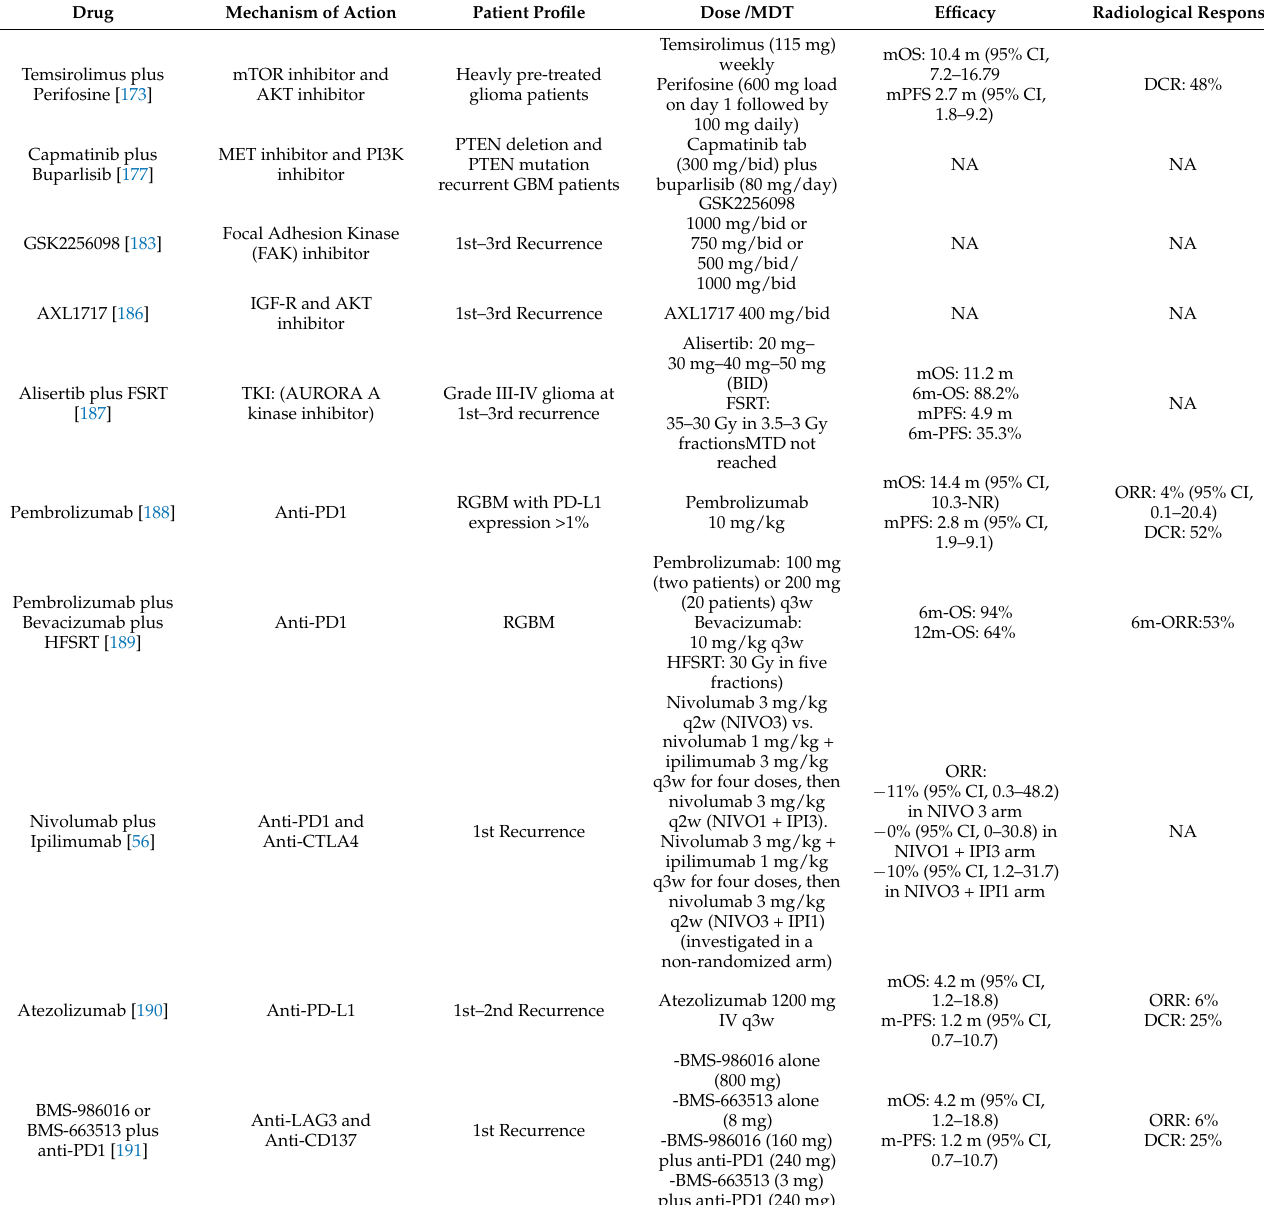
Table 5. Summary of recent phase I